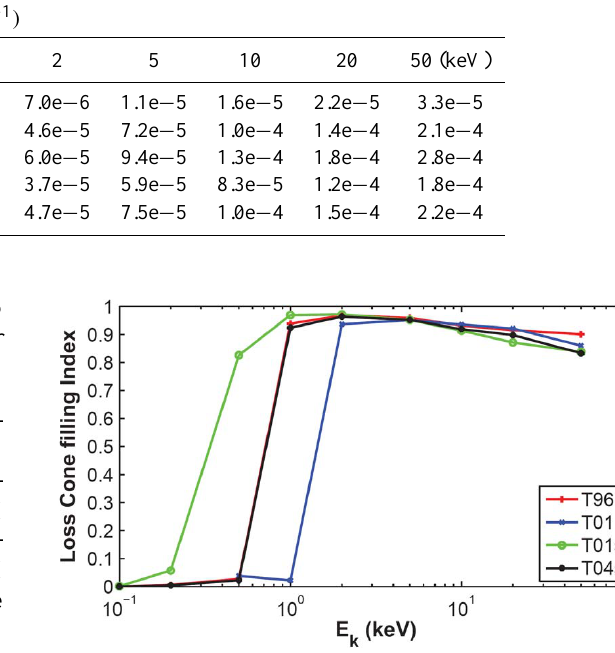
Figure 6 . Estimated loss cone filling index, based on equation (4), for the nine energies 643 Fig. 6. Estimated loss cone filling index, based on Eq. (4), for the nine energies (100eV, 200eV, 500eV, 1keV, 2keV, 5keV, 10keV, (100 eV, 200 eV, 500 eV, 1 keV, 2 keV, 5 keV, 10 keV, 20 keV, and 50 keV) of plasma 644 20keV, and 50keV) of plasma sheet electrons, corresponding to use sheet electrons, corresponding to use of color-coded Tsyganenko models. 645 of color-coded Tsyganenko